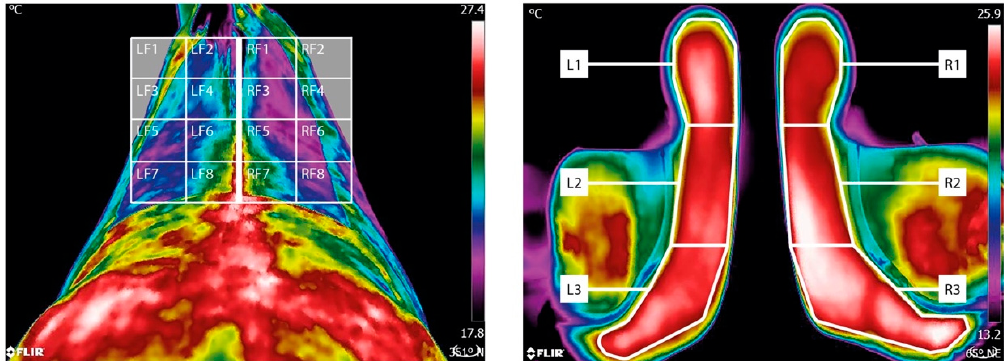
Figure 3—Thermal Grid Reference for the Thoracic Region and Underneath of the Saddle.